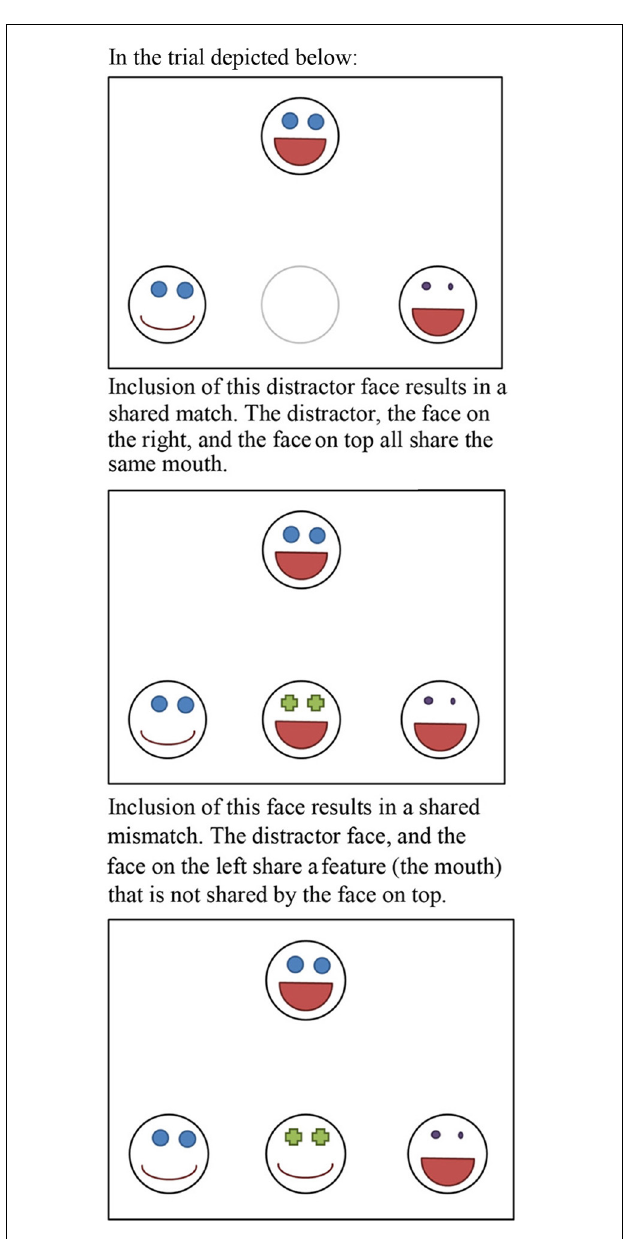
FIGURE 4 | Illustration of a shared-match and a